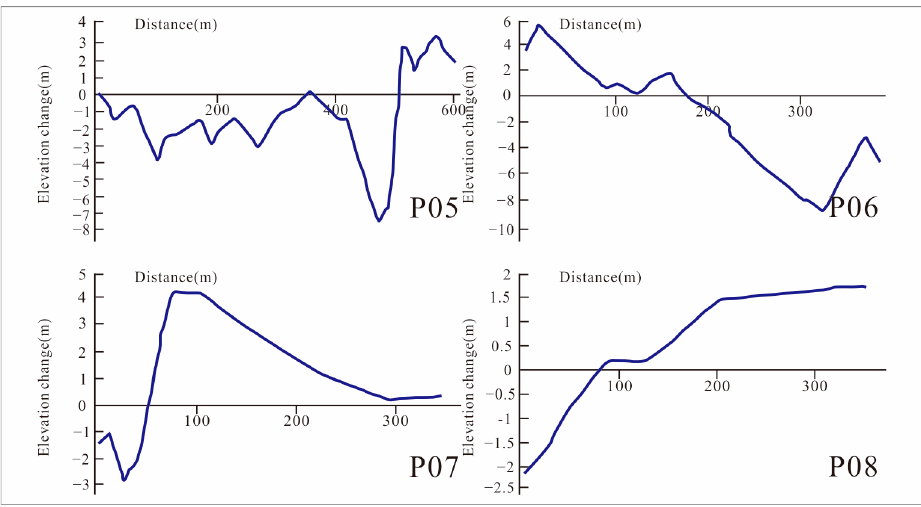
Figure 8. Elevation change in cross-section (P01 to P04).